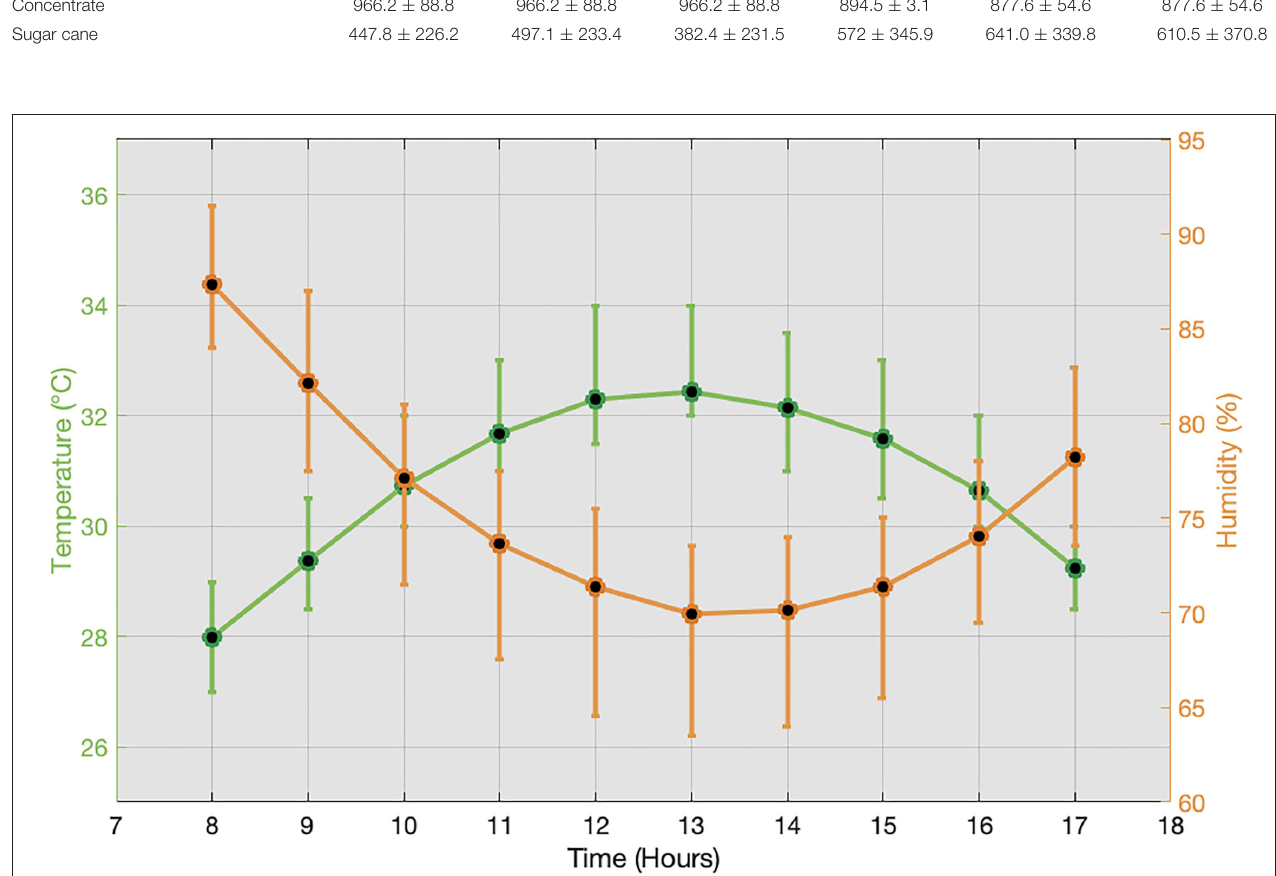
FIGURE 1 | Daily climatic fluctuation of average ambient temperature (green) and average relative humidity (orange) in the pig building facility. Errors bars give the 25% and 75% quantiles found on the data over the 54 monitoring days.